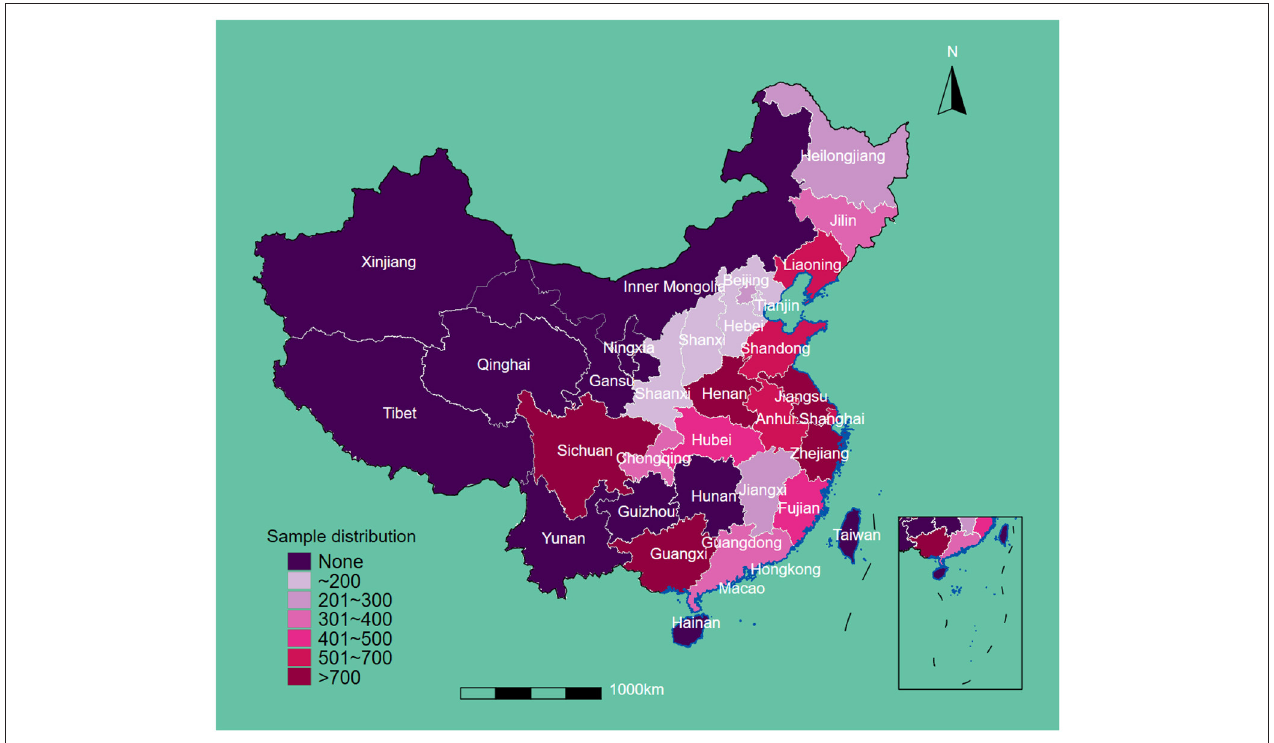
FIGURE 1 | Sample